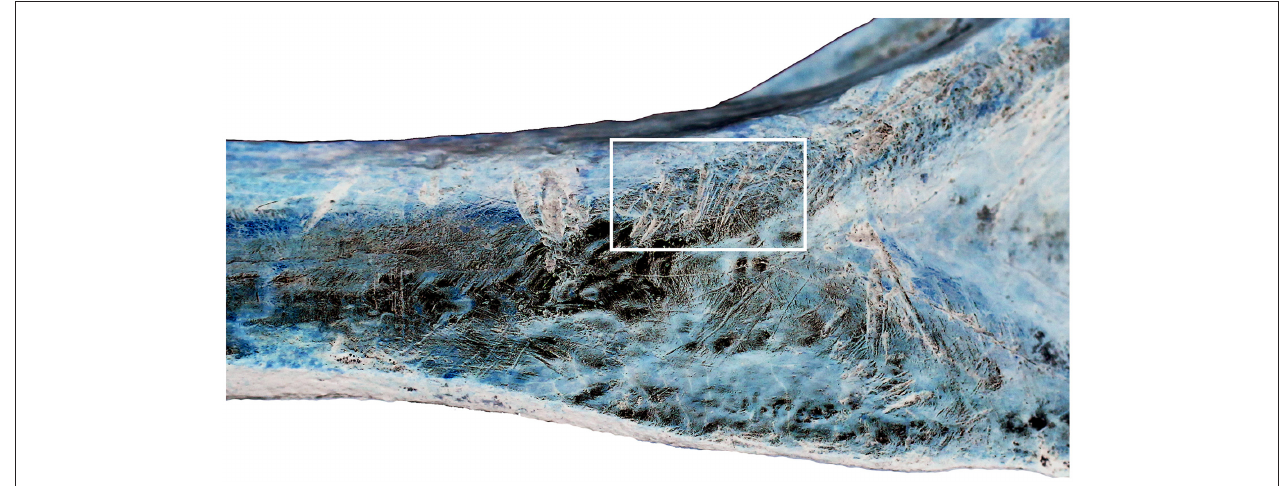
FIGURE 1 | OUM 14342A, Palaeopropithecus ingens distal humerus (L) adjusted in Adobe Photoshop to highlight areas with bone damage. Perez et al. (2005) “cut marks” enclosed by white rectangle, but note similar and extensive damage elsewhere that is probably non-cultural (Copyright Anderson and